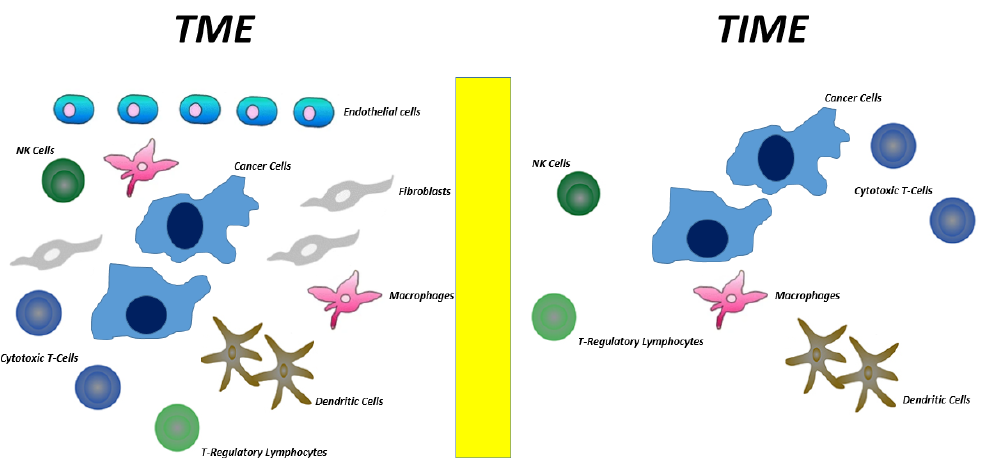
Figure 2. Differences between TME and TIME.